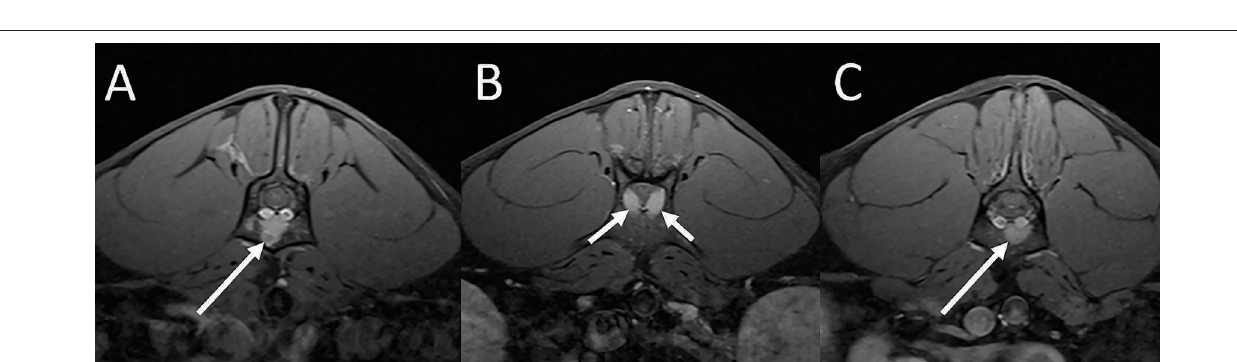
spinal cord compression. Differential diagnoses